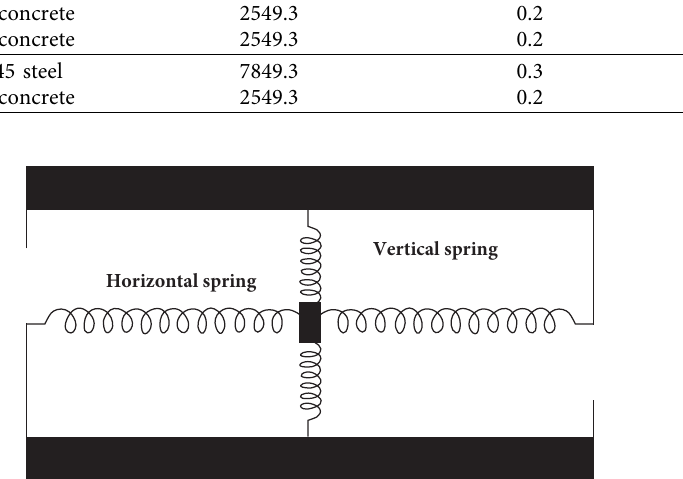
Figure 2: Equivalent schematic diagram of lead rubber Table 2: Material parameters of submarine site overburden layer.